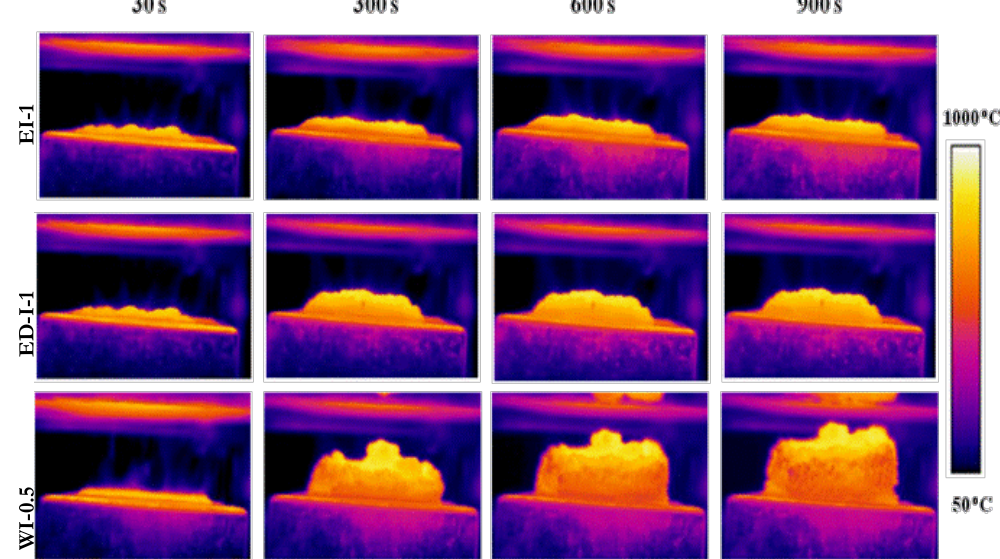
Figure 7. The intumescent char formation of EI-1mm, ED-I-1mm and WI-0.5mm during mass loss calorimetric test at 50 kW/m 2 for 900s.